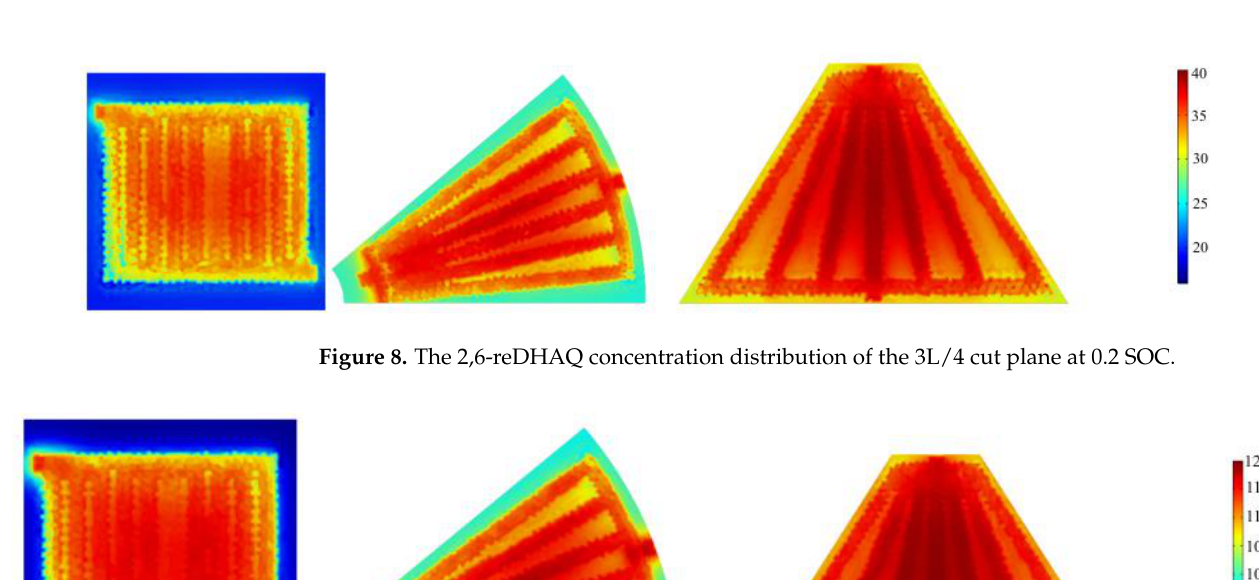
Figure 7. Diagram of the electrode sections.